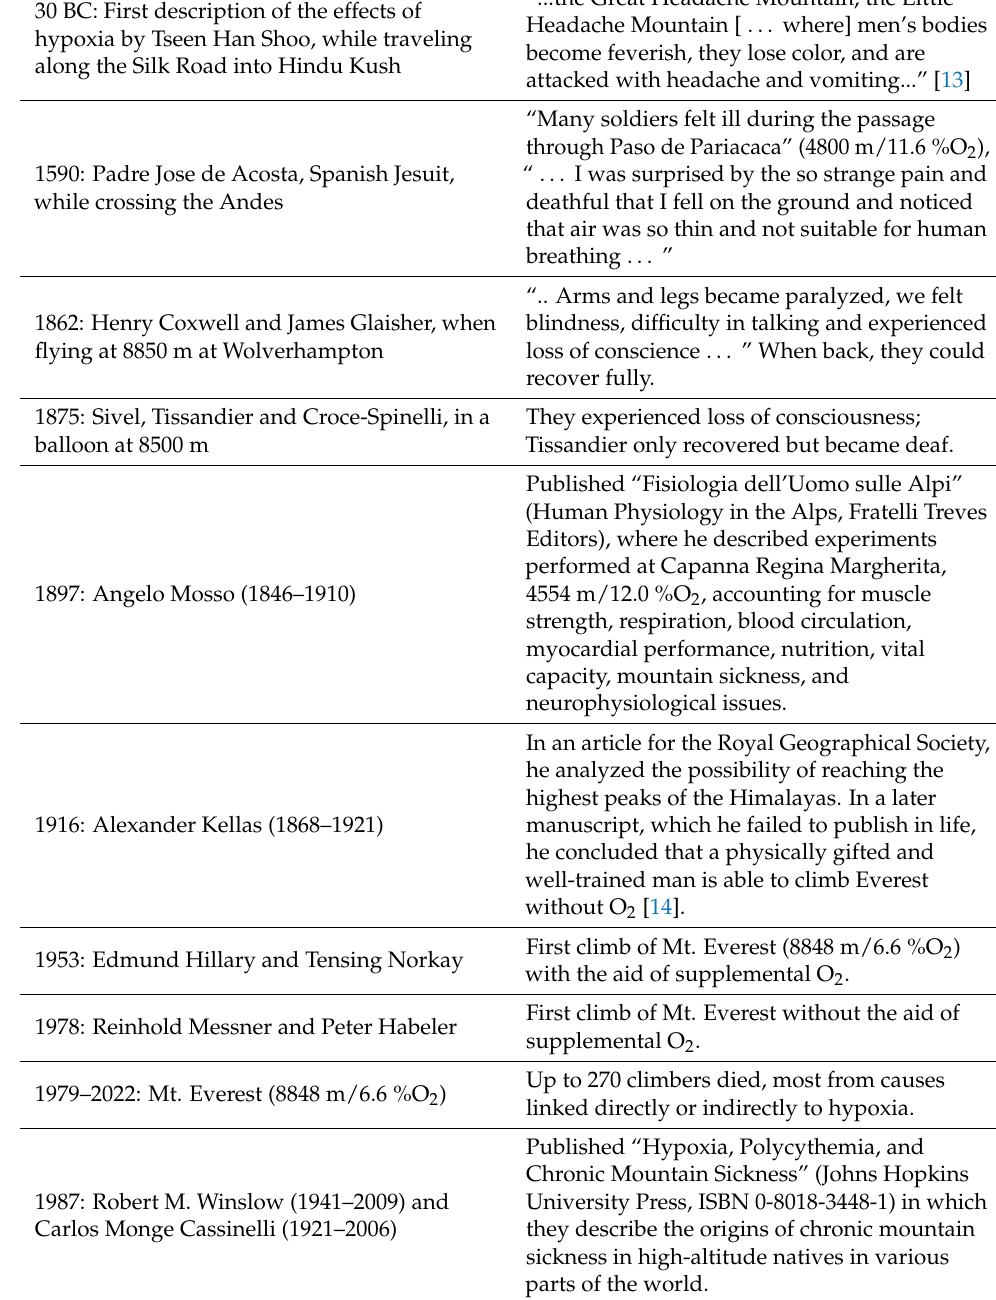
Table 1. A few historical excerpts on the impact of hypoxia on mankind. 30 BC: First description of the effects of hypoxia by Tseen Han Shoo, while